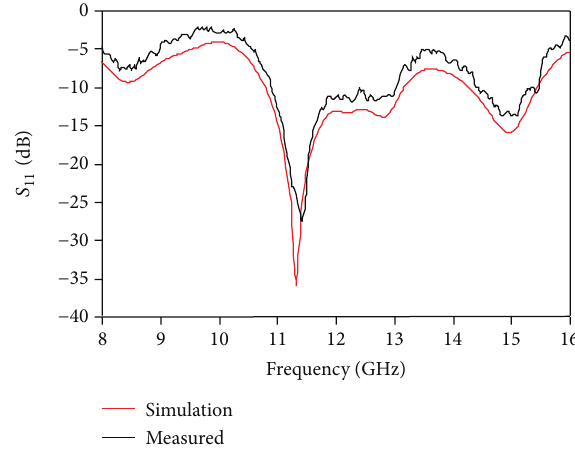
Figure 9: Comparisons between simulated and measured return loss on FR4 material.